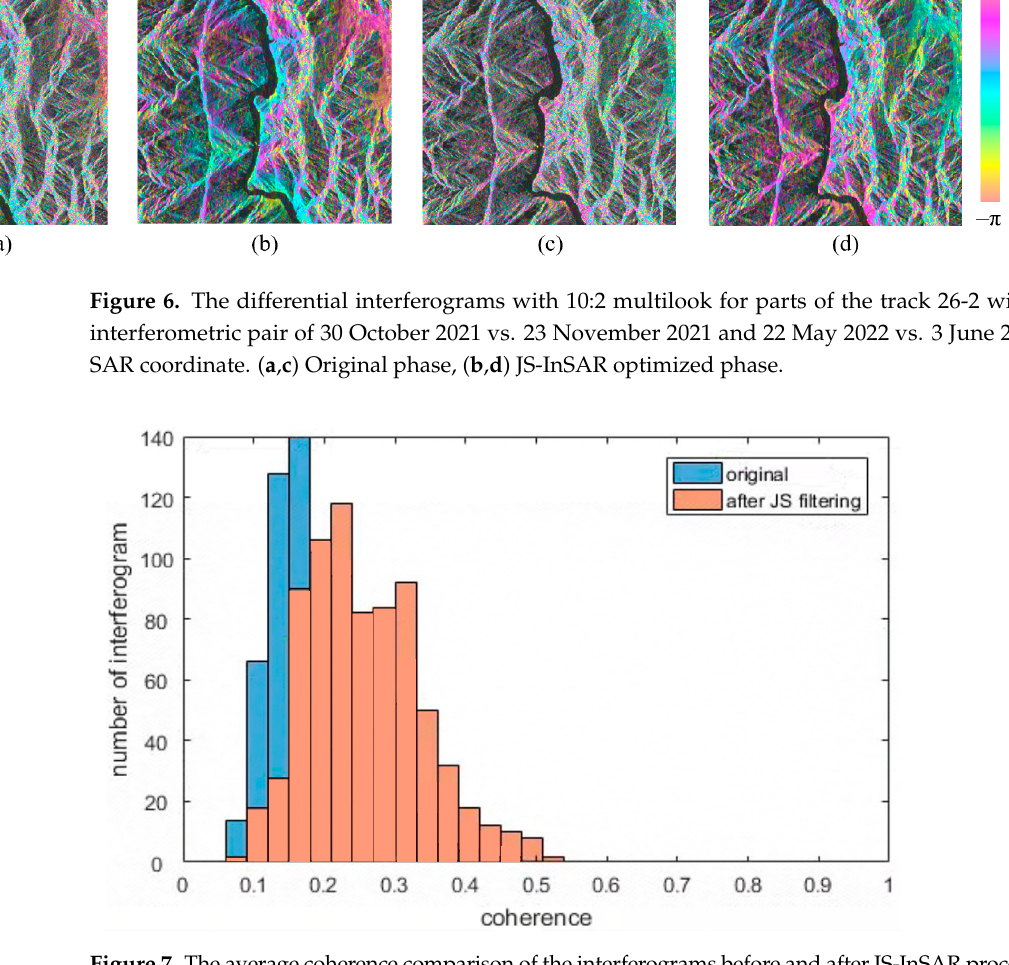
Figure 7. The average coherence comparison of the interferograms before and after JS-InSAR pro-